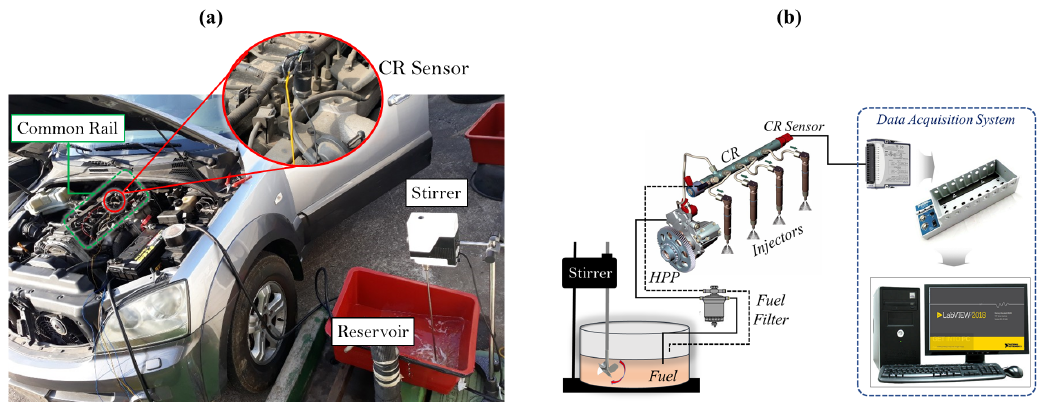
Figure 2. A view of ( a ) the actual experiment setup, ( b ) schematic view of the experimental